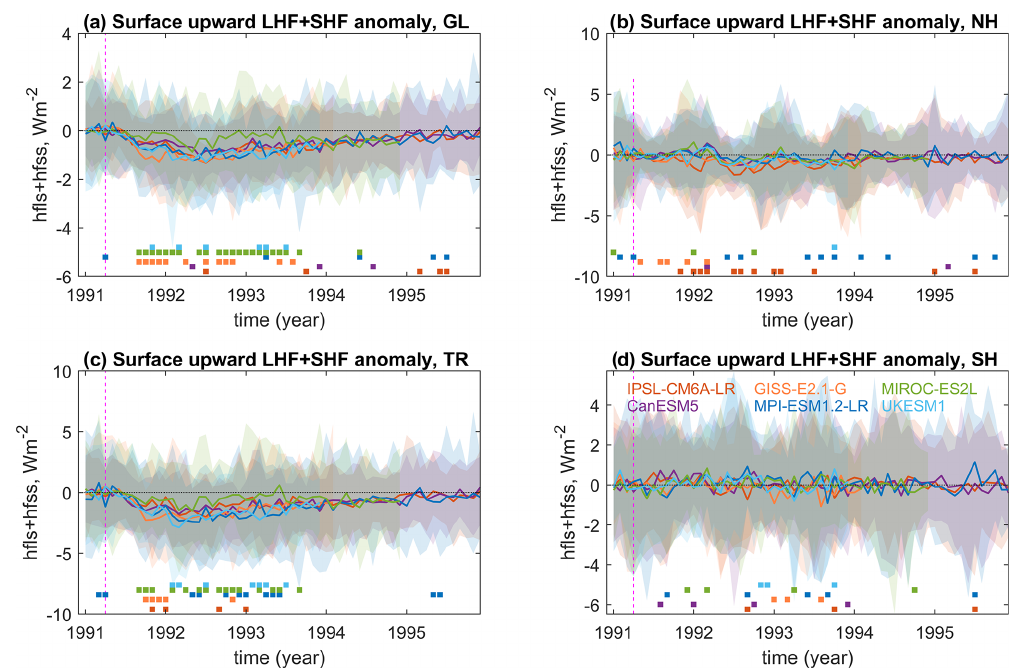
Figure 6. Same as in Fig. 5 but for surface upward vertical latent heat flux (LHF) plus sensible heat flux (SHF) (or hfls + hfss).